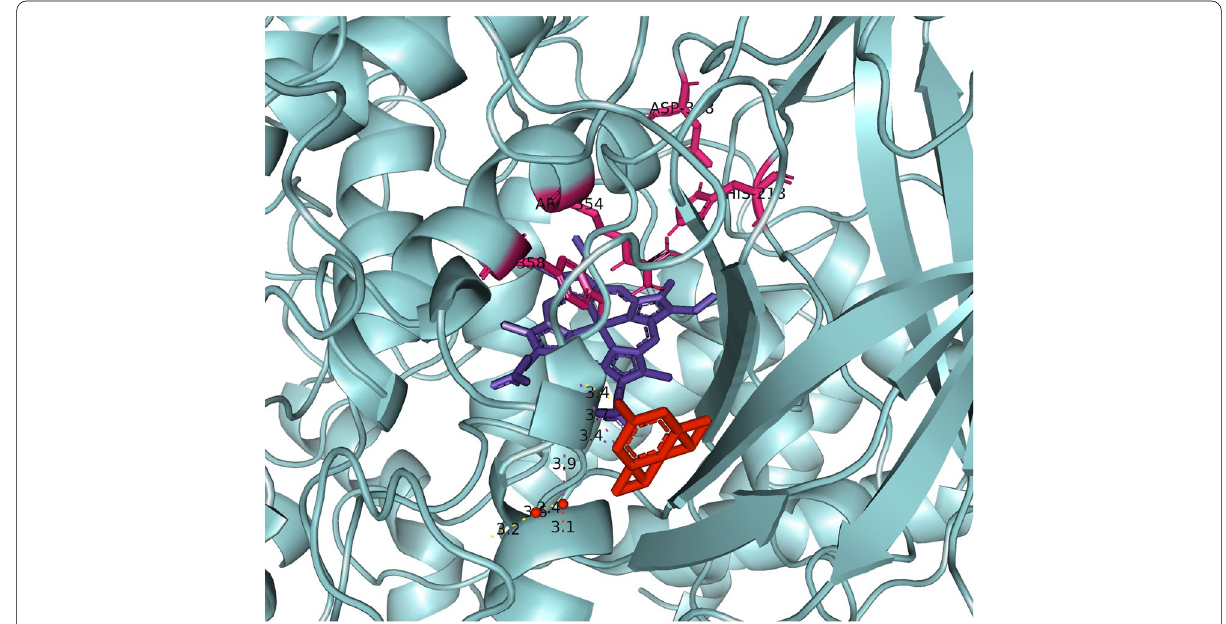
Fig. 5 Closer look at the interaction between halogenated boroxine and human